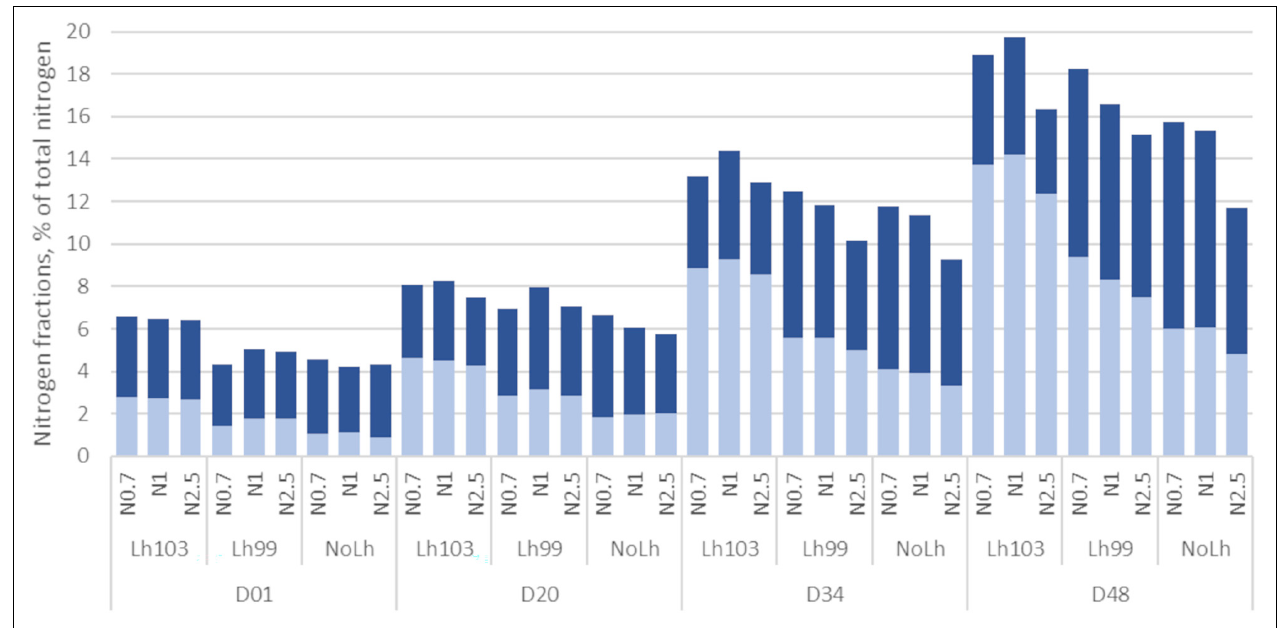
FIGURE 3 | Changes in nitrogen fractions during the ripening of Swiss cheese manufactured with different Lactobacillus helveticus strains and NaCl content. Non-casein nitrogen (NCN, total bar) correspond to the pH4.6-soluble N, non-protein N (NPN, light blue) to the 12%TCA-soluble N. The difference “NCN minus NPN” is shown in dark blue. Values are means of three, or two for NoLh cheeses, biological replicates, and expressed as percentage of total nitrogen. Samples codes are as follows: D01, D20, D34, D48: ripening stage, in days. L. helveticus strain: Lh103 (CIRM-BIA103), Lh99 (CIRM-BIA99), or NoLh (without L. helveticus ). NaCl content: N1 (regular salt concentration, i.e., 0.45 g NaCl/100 g cheese), N0.7 (N1 × 0.7), and N2.5 (N1 ×